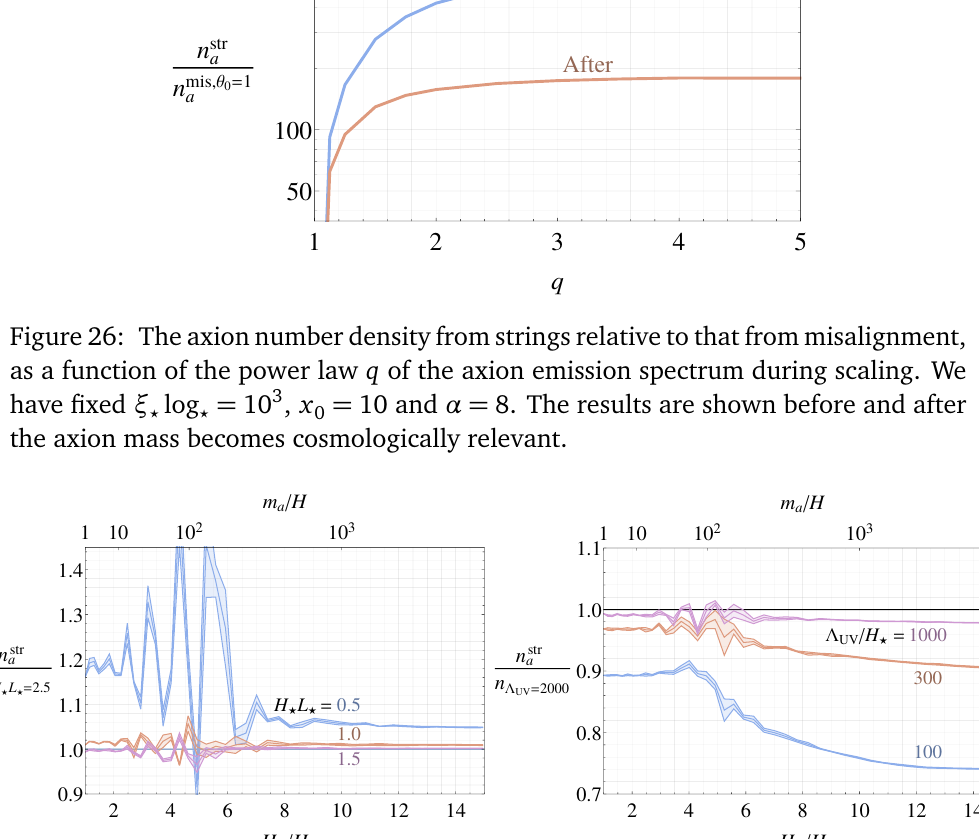
Λ / H = 2000. The (cid:63) UV = 10 0